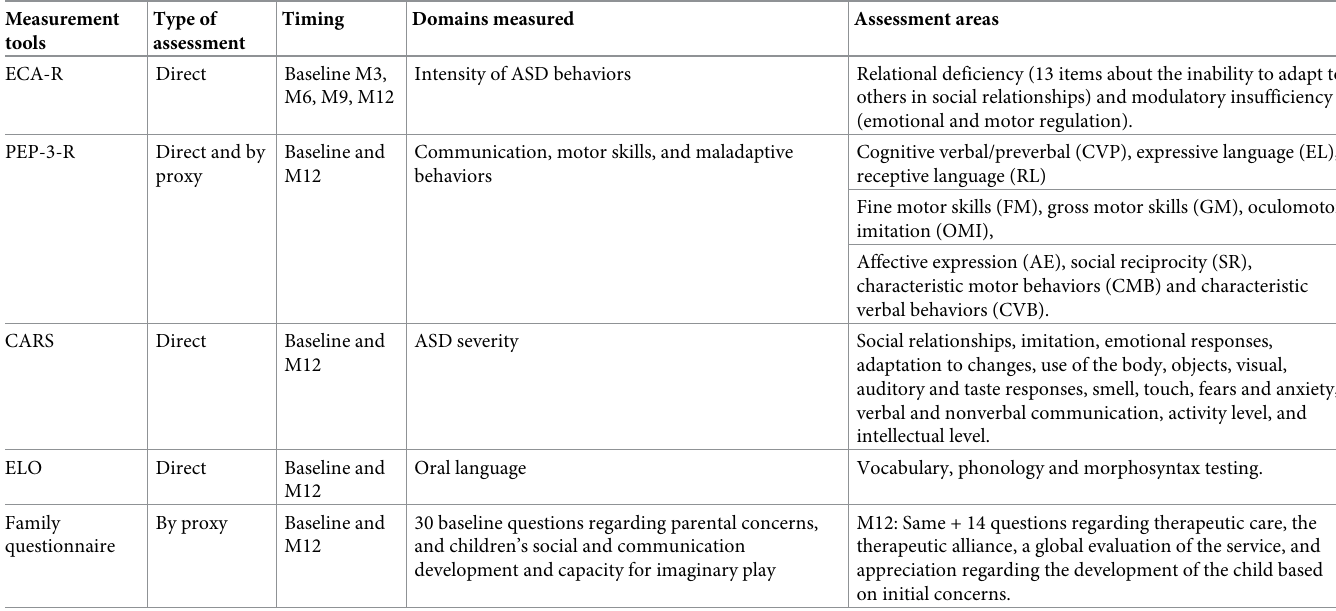
Table 1. Brief overview of outcome